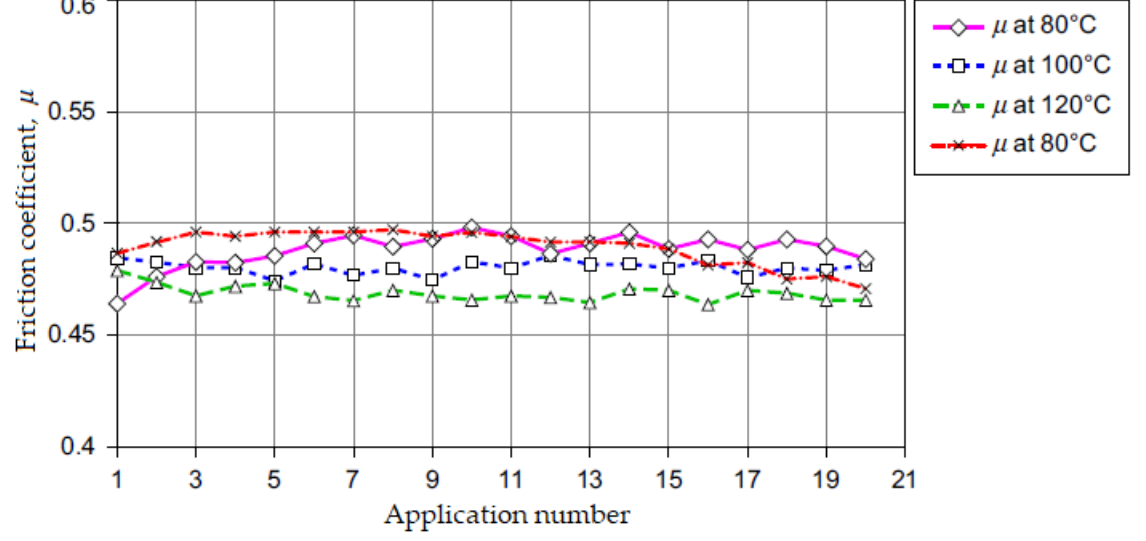
Figure 6. Measurement of the friction coefficient, μ in a device for testing brake material samples at different disk temperatures as a function of time and linear slip velocity of 7.15 m/s (reprinted/adapted with permission from ref. [13]. 2022, Elsevier).